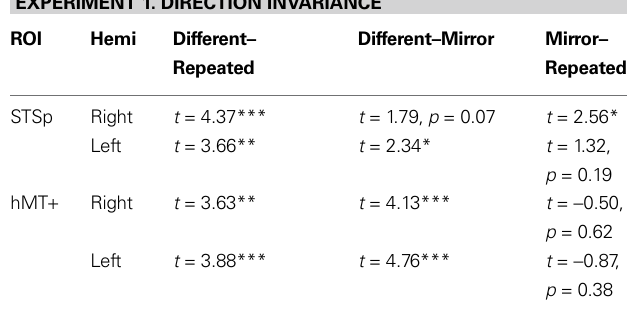
Table 2 | The results of planned statistical contrast on the deconvolved hemodynamic response functions from the STSp and hMT + , for Experiments 1, 3 and